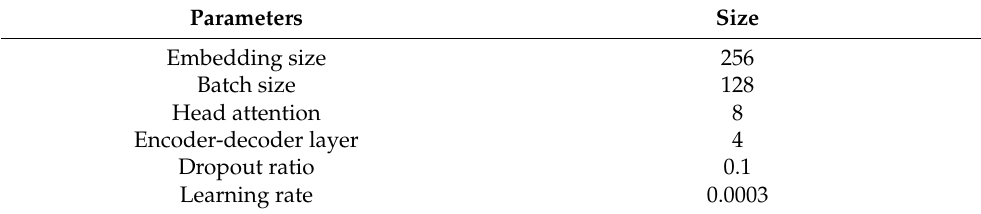
Table 2. Size of parameters. Parameters